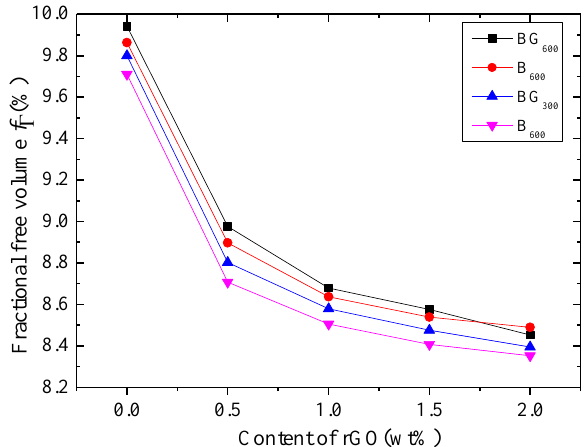
Figure 5. Positron annihilation spectra of the free volume fraction of graphene.